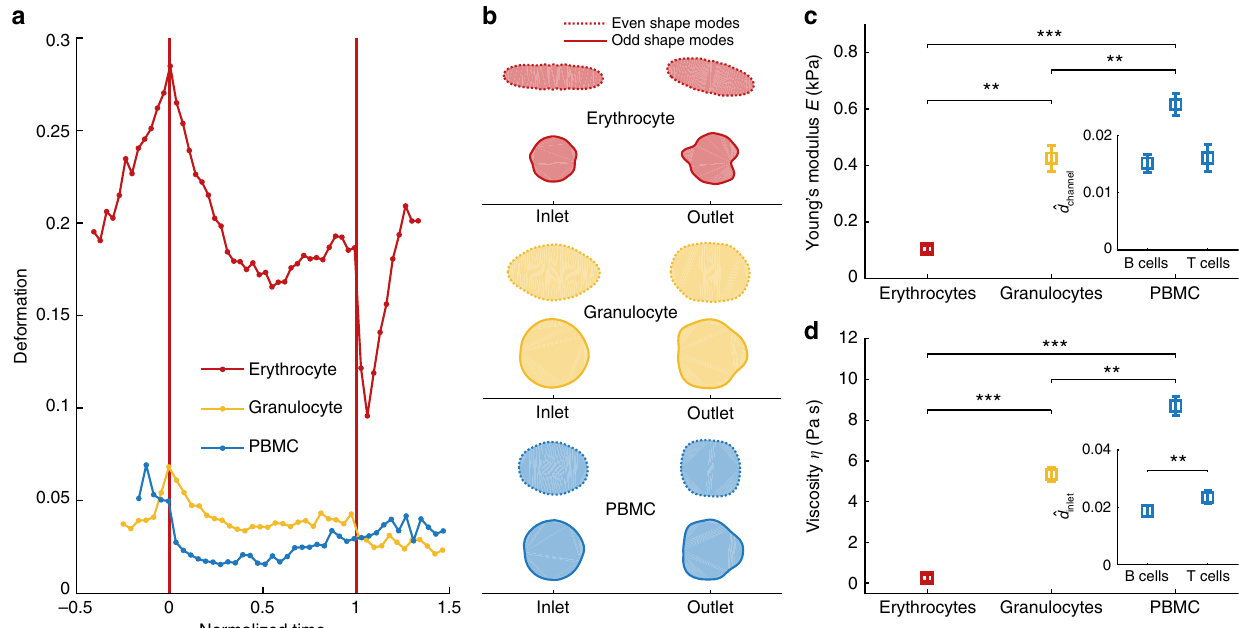
Fig. 4 Single cell rheology on peripheral blood cells. a Dynamic RT-DC traces of individual cells in whole-blood showing erythrocytes (red), granulocytes (yellow) and peripheral blood mononuclear cells (PBMC, blue). Translocation time has been normalized to account for different velocities. b Cell shapes of typical blood cells reconstructed from even (dashed line) and odd (solid line) shape modes showing erythrocytes (red), granulocytes (yellow) and PBMCs (blue). c Apparent Young ’ s modulus E and d apparent viscosity η of puri fi ed cell samples. Insets show a comparison of the peak channel deformation ^ d c and the peak deformation ^ d d for B cells and CD4 + T cells at the inlet. Statistical analysis in c and d includes data of three biological replicates channel inlet from n = 381 erythrocytes, n = 243 granulocytes, n = 130 PBMCs, n = 737 B cells and n = 3079 CD4 + T cells. Experiments have been carried out in a 20 × 20 µ m channel at a fl ow rate of 4 nl s − 1 . The mean shear rate of 9700 s − 1 and a mean stress of 216 Pa on the cell surface (granulocytes and PBMCs) as well as the mean shear rate of 8600 s − 1 and a mean stress of 128 Pa on cell surface (erythrocytes) has been derived from fi nite element method simulations considering the full micro fl uidic geometry. Statistical signi fi cance has been calculated from linear mixed models and error bars represent standard error of the mean (** p < 0.01; *** p <